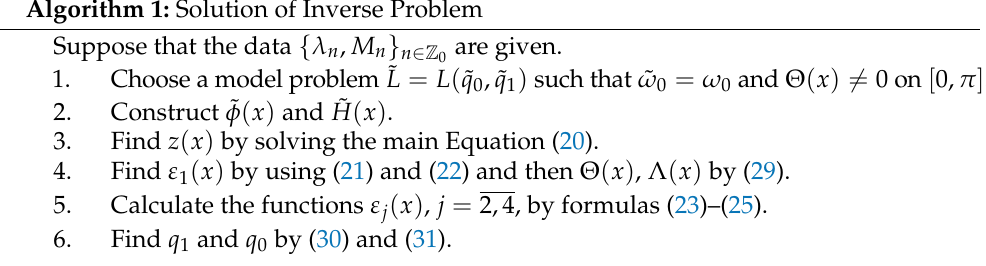
Algorithm 1: Solution of Inverse